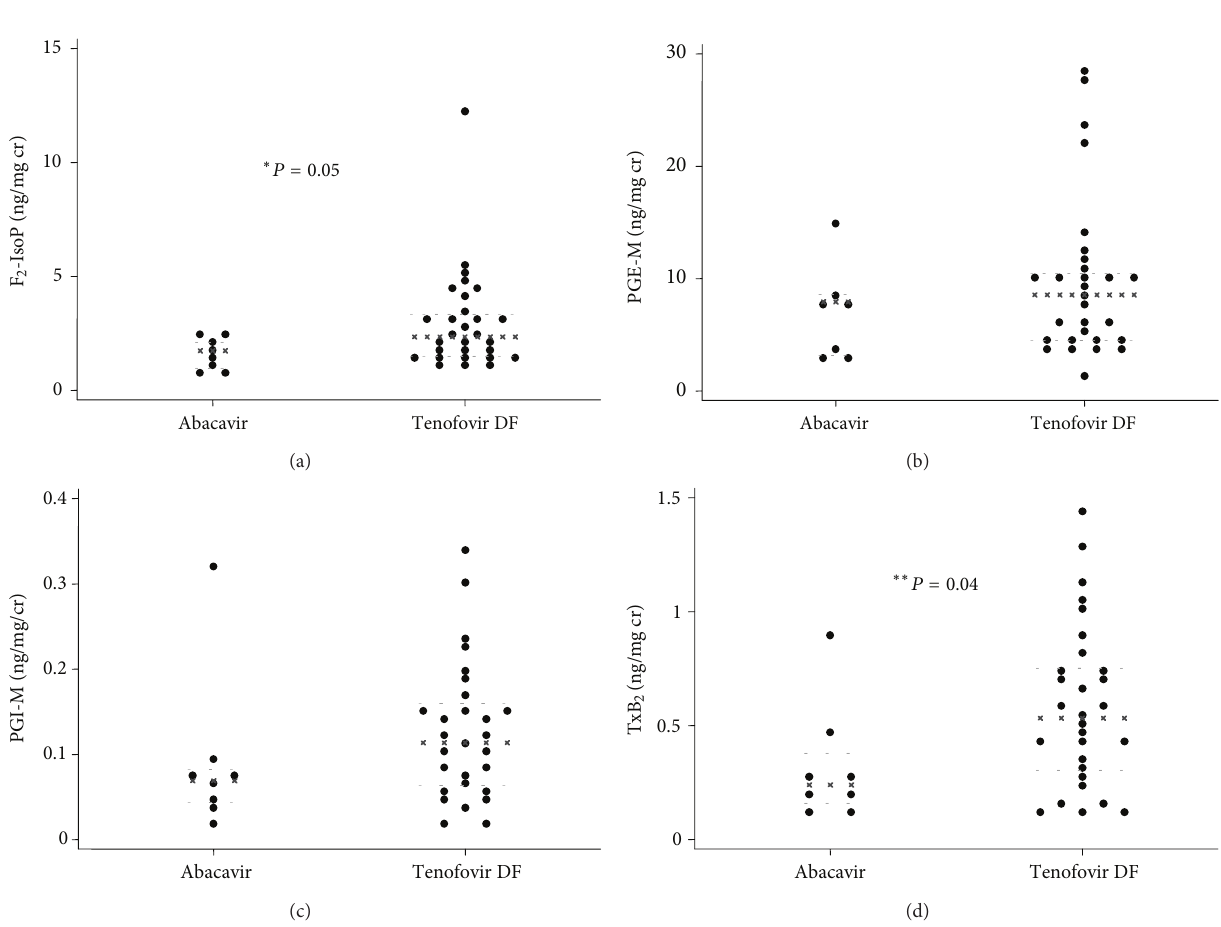
7.9 [4.0-10.0]; 𝑃 = 0.11 ), in a multivariate model,